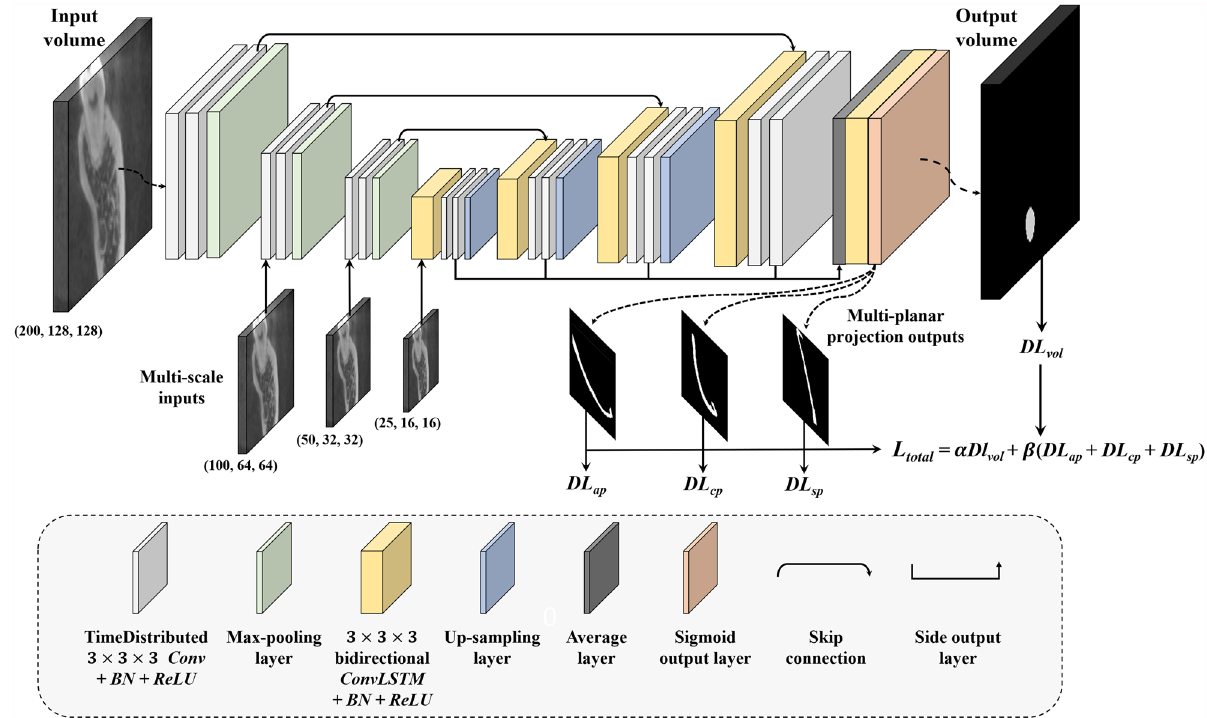
Figure 1. The Canal-Net architecture with a 3D encoder-decoder under a multi-task learning framework consisting of time-distributed convolution blocks, multi-scale inputs, skip connection, and bidirectional convolutional LSTM (ConvLSTM) with side-output layers. The bidirectional ConvLSTM was utilized to capture anatomical context information, and a multi-task learning approach was performed to learn overall MC volume and structural